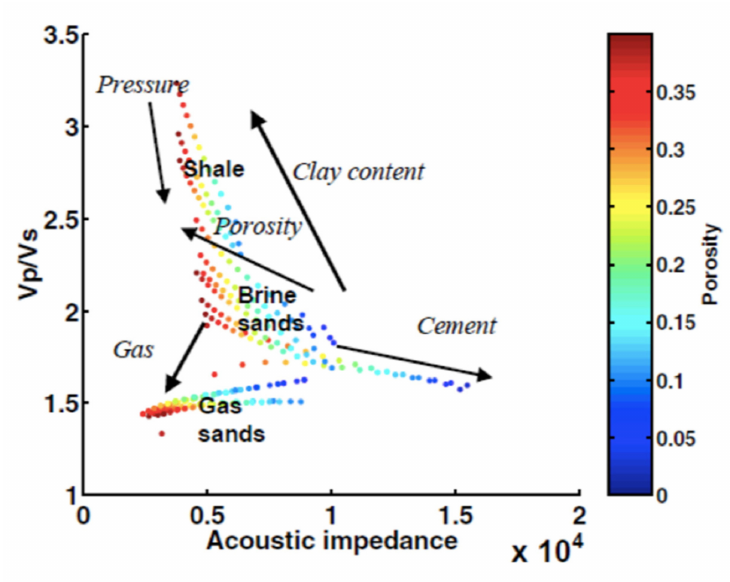
Figure 2. Example of V p / V s ratio vs. acoustic impedance (AI) reservoir characterization